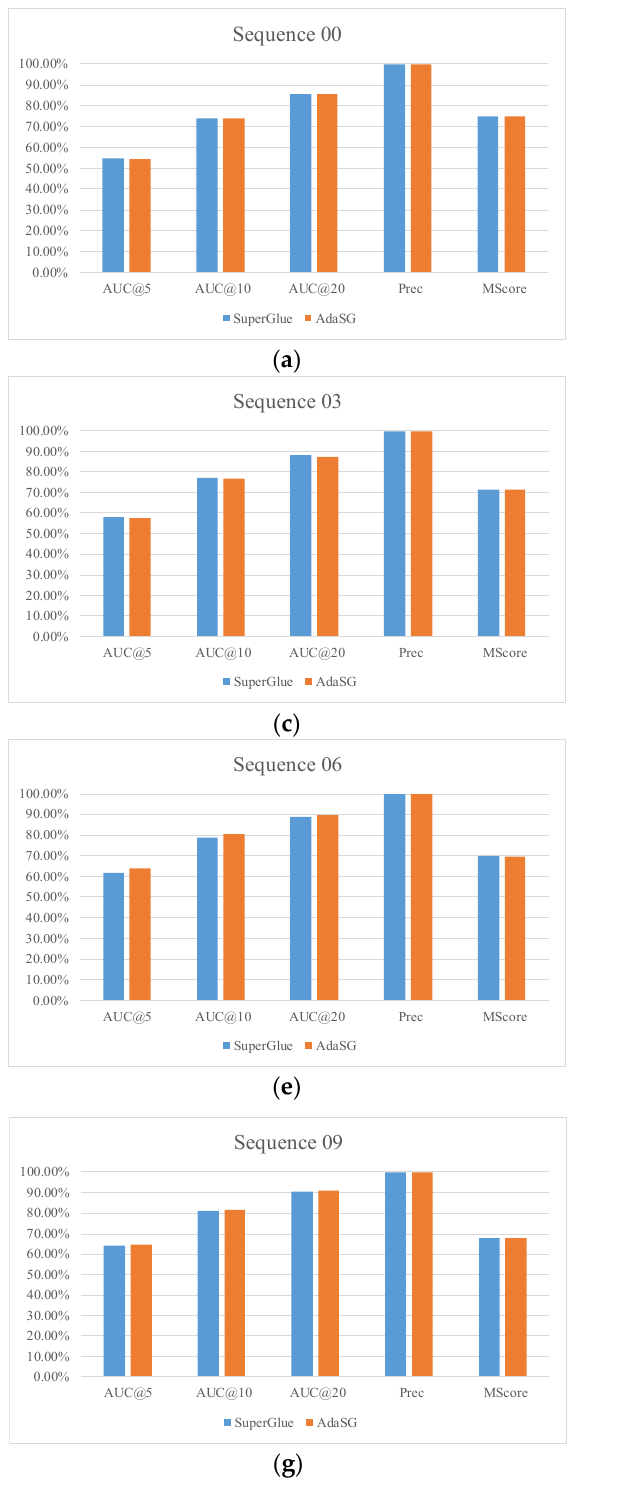
Figure 15. The runtime for different sequences of KITTI.